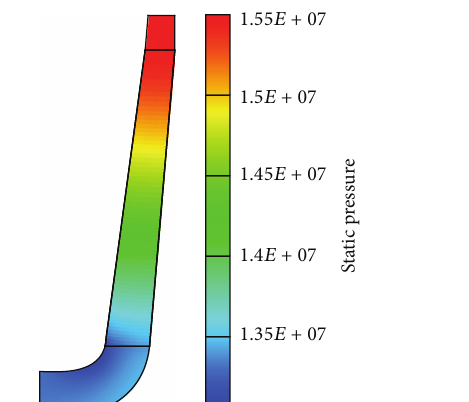
Figure 11: Impeller performance curves.